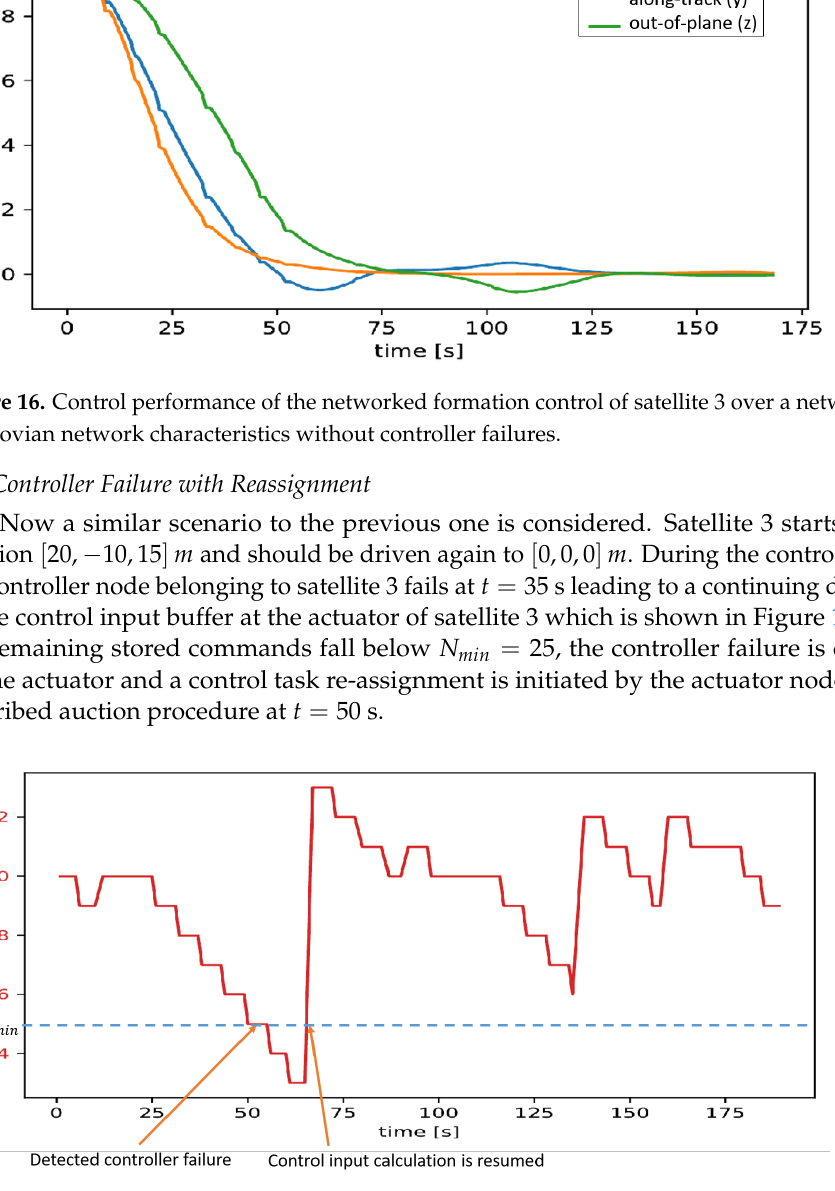
Figure 17. Command buffer state on actuator side under the influence of packet losses. In addition at t = 35 s the currently assigned controller node fails and a control task reassignment is initiated once the remaining control input buffer size to falls below N min . After the task is reassigned the control input buffer at the actuator is filled